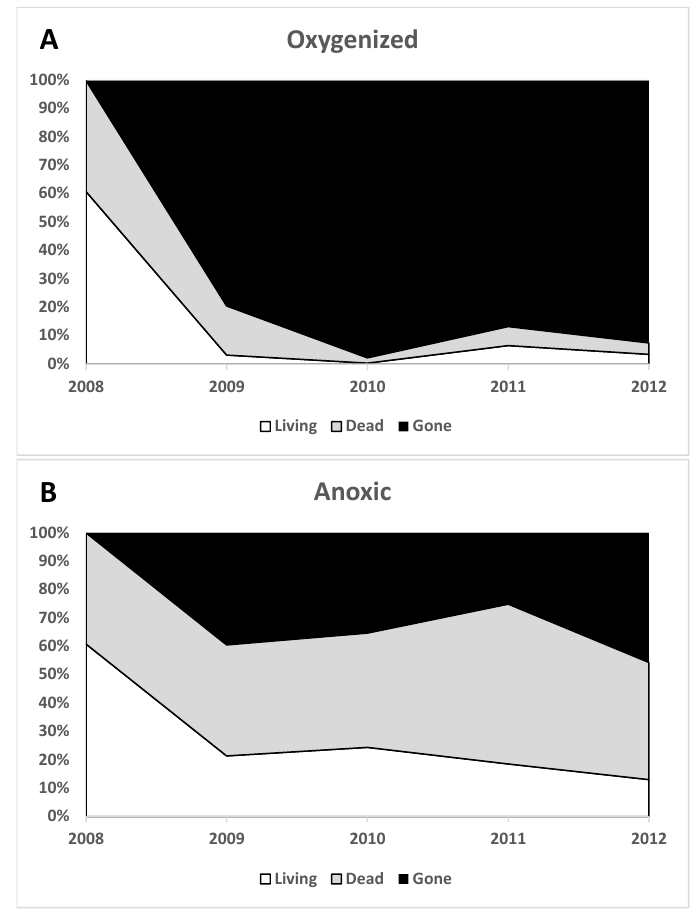
C Figure 2. Cont